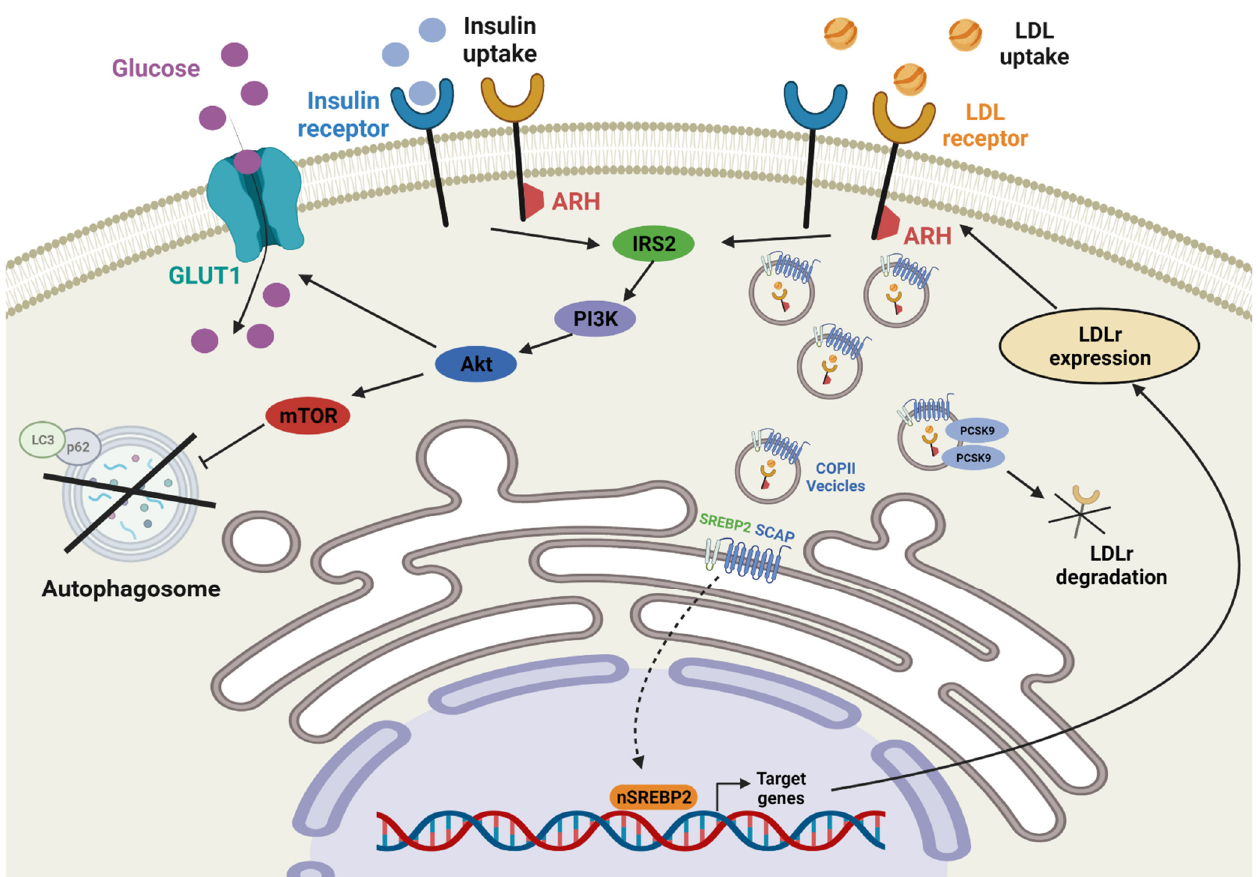
Figure 1. Interaction of low-density-lipoprotein receptor ( LDLr ) and insulin receptor (IR). The process of the expression of LDLr and endocytosed downstream molecules to regulate cholesterol homeostasis and the association of co-localized IR.